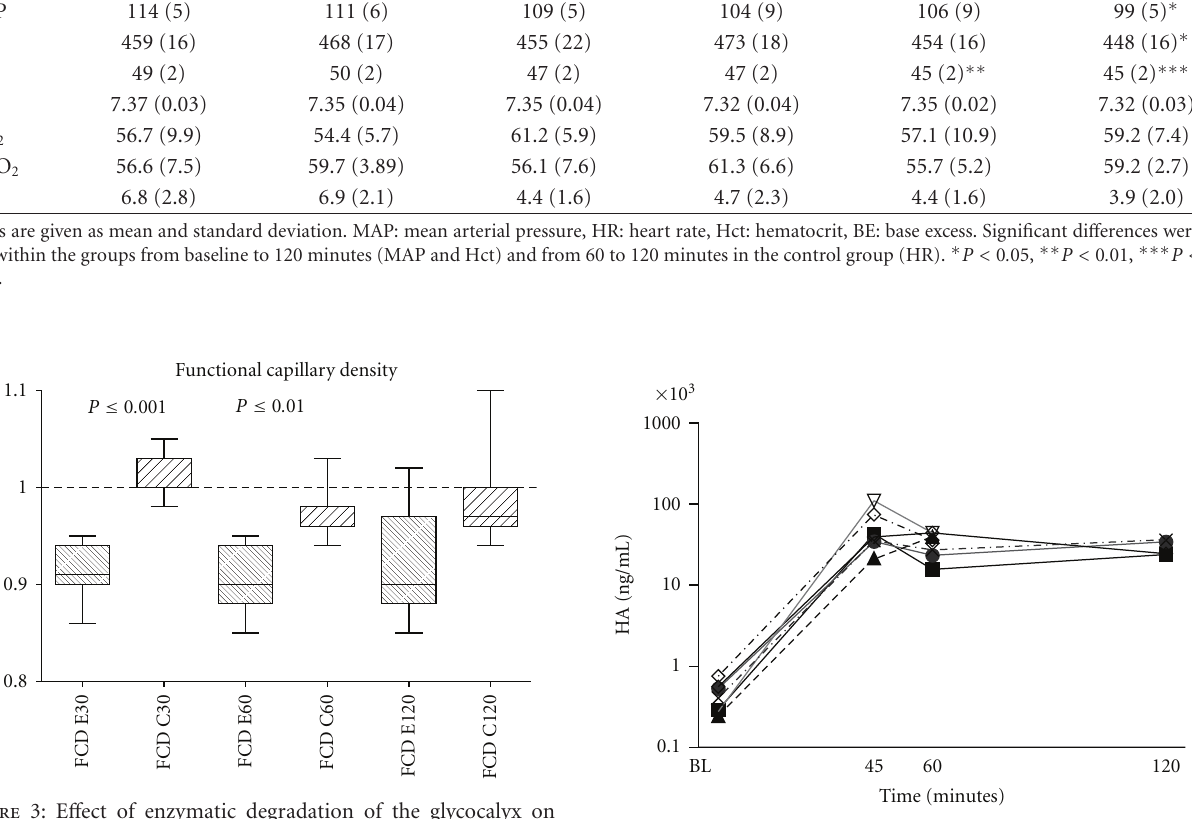
Figure 4: Plasma levels of hyaluronan (HA) for the 7 animals treated with hyaluronase displayed on a logarithmic axis. Plasma level of HA from each animal is indicated by a single line based on measurements obtained at baseline (BL), after 45, 60, and 120 minutes. At 120 minutes, HA was measured in 4